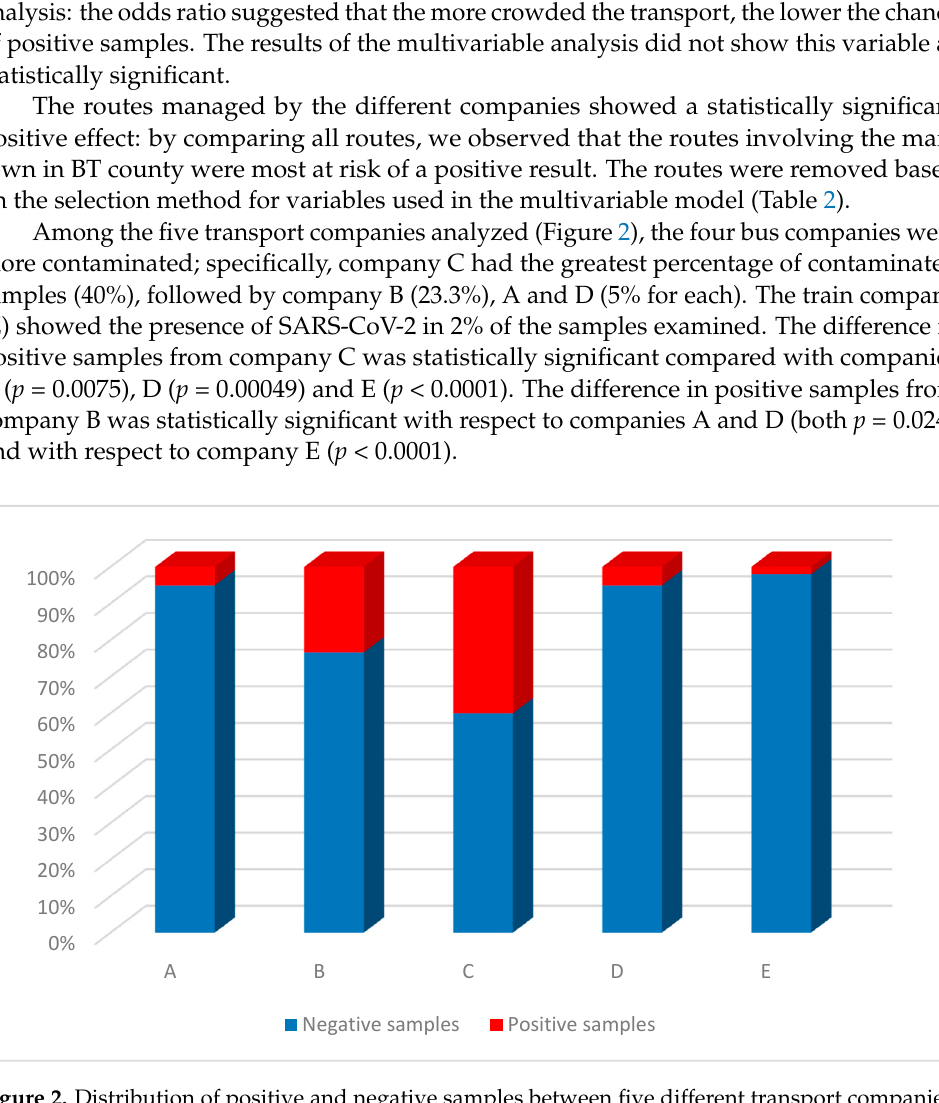
Figure 2. Distribution of positive and negative samples between five different transport companies.